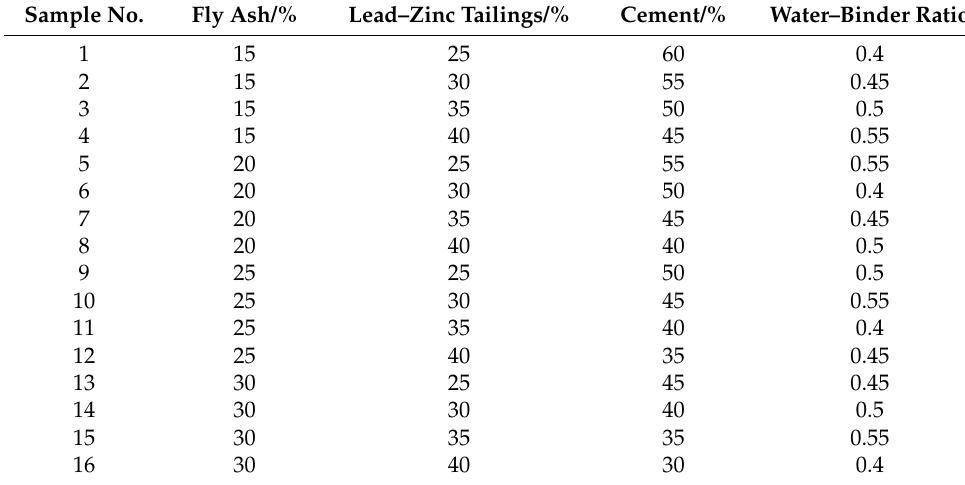
Table 3. Mix proportions of